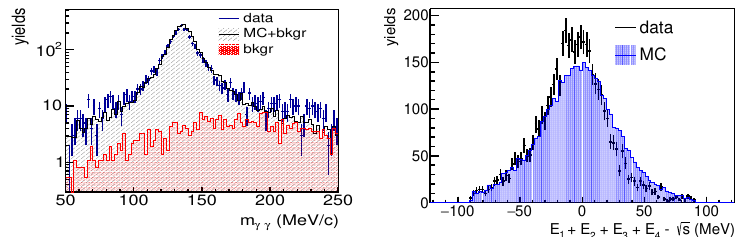
Figure 2. (left) The γ 3 γ 4 mass spectrum for e + e − → 2 π 0 π + π − events at E c . m . = 1 . 5 GeV. (right) The di ff erence of the total reconstructed energy of pions and E c . m . = 1 . 5